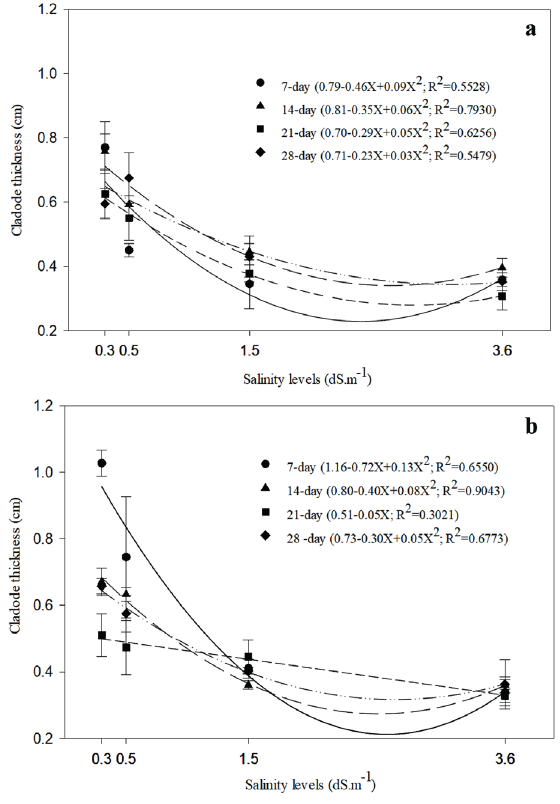
Figure 3 - Cladode thickness (cm) of cactus pear cv. Miúda according to the irrigation frequency, salinity level (7-day: line solid; 14-day: line long dash; 21-day: line short dash and 28- day: line dash-dot-dot) and soil type ( a : Sandy and b : Sandy loam). Error bars represent the standard error of the mean.